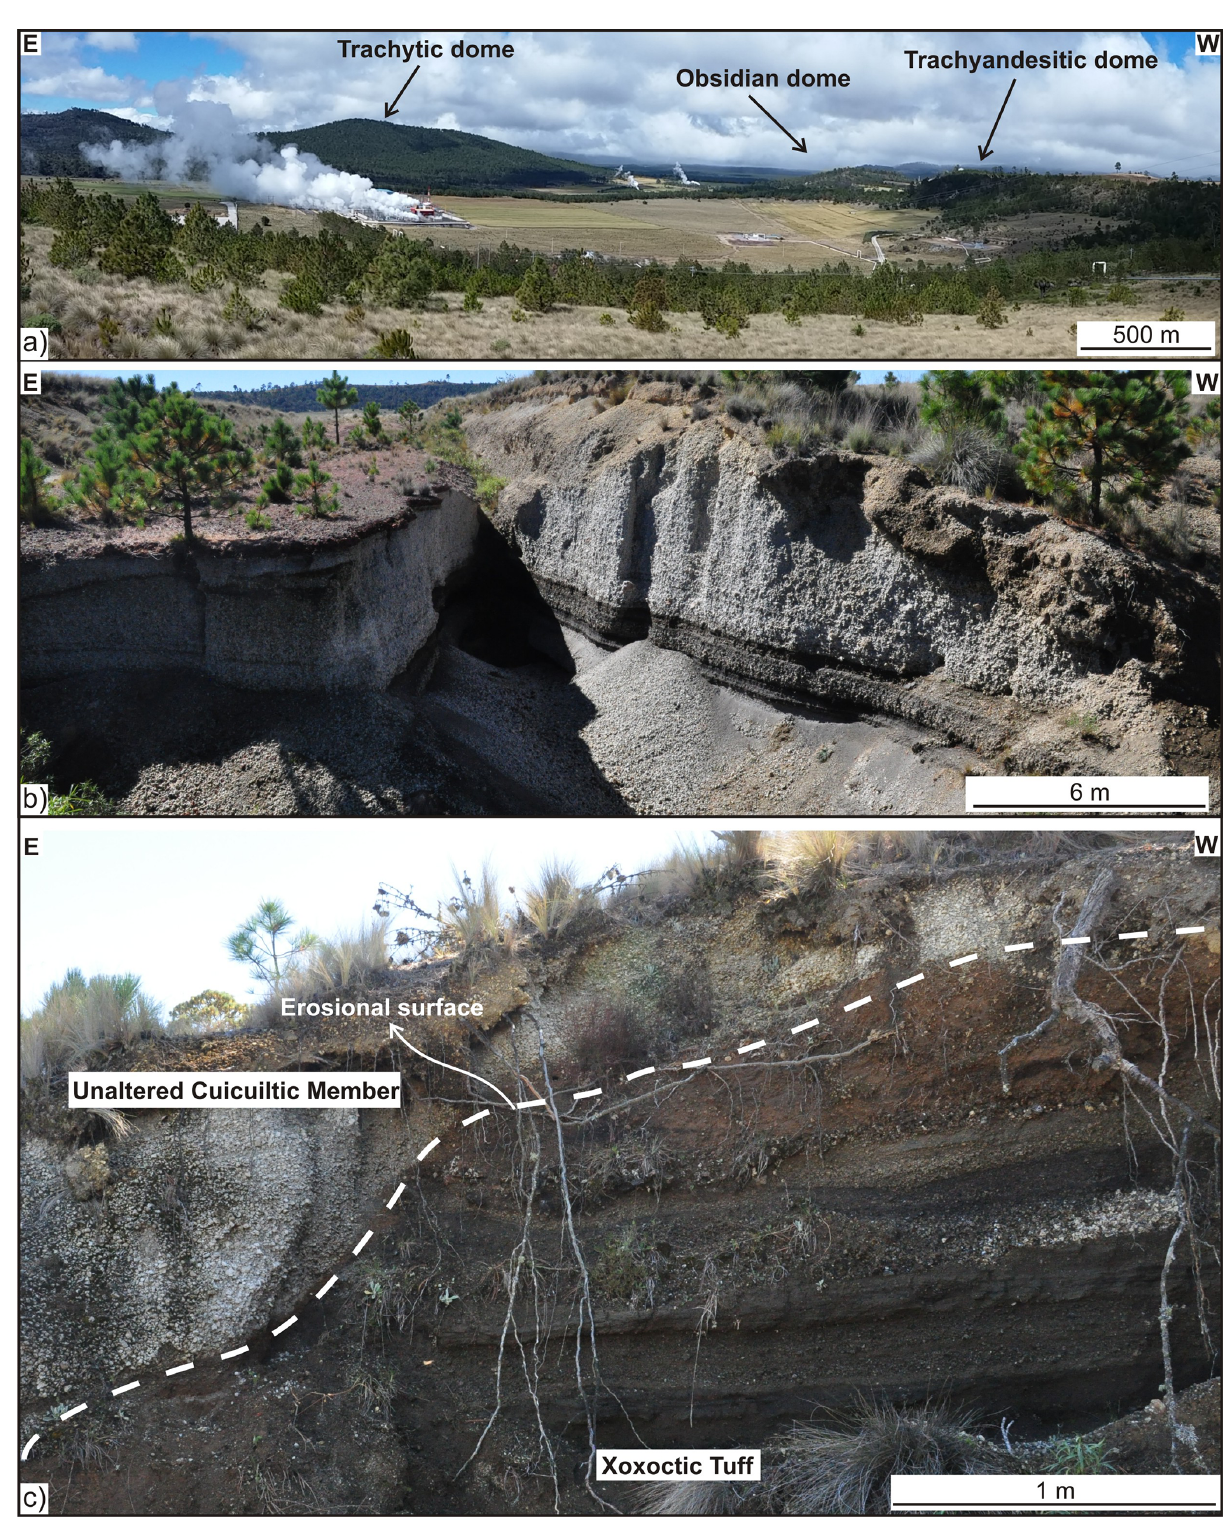
Figure 5. (a) Panoramic view from Xalapasco crater (looking towards N) of the lava domes aligned N–S. (b) Unaltered Cuicuiltic Member (LH-07). (c) Unaltered Cuicuiltic Member covering a layered pyroclastic deposit, which can be laterally correlated with the Xoxoctic Tuff (LH-08). The erosional surface preceding the deposition of the Cuicuiltic Member is shown (dashed white